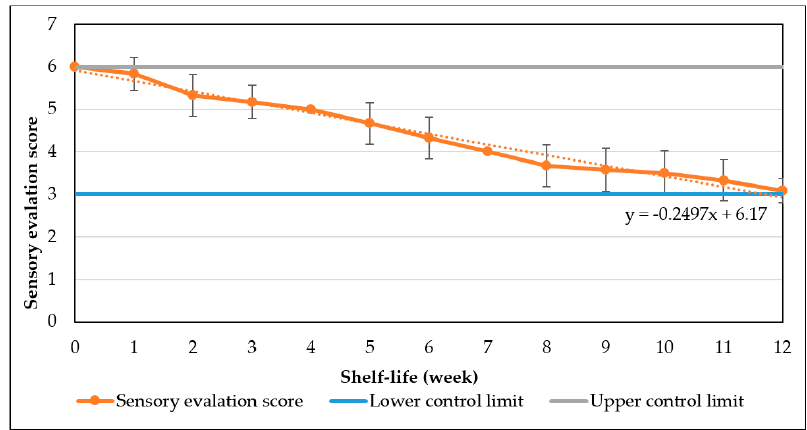
Figure 10. Sensory evaluation score in air-cooled condition 20 °C after various storage times.